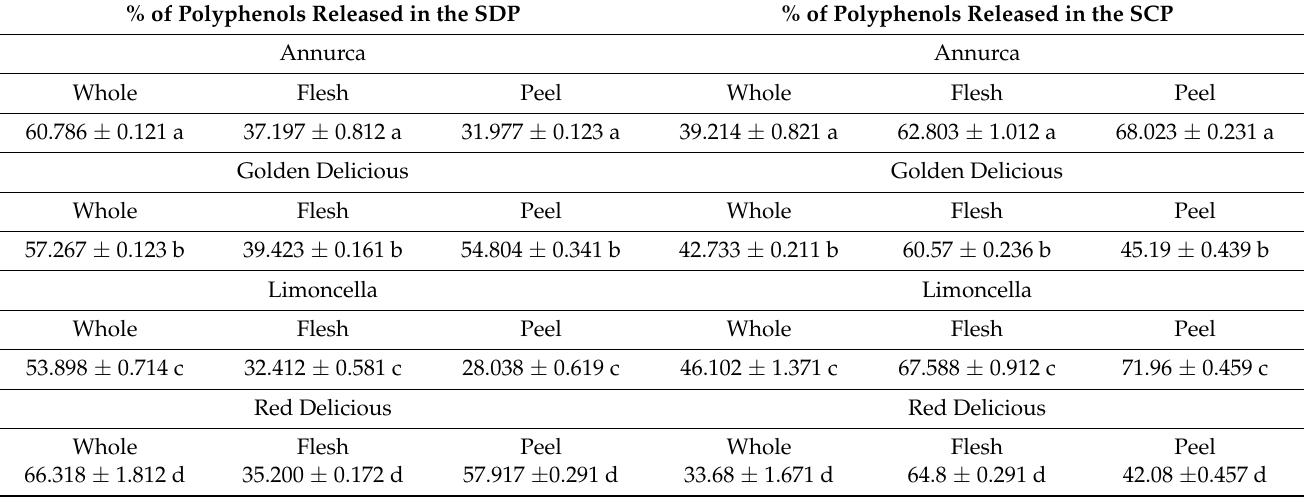
Table 7. % of polyphenols released in the soluble duodenal phase (SDP) and in soluble colonic phase (SCP) upon enzymatic digestion of apple sample. Each value represents the mean of three replicates. Different letters denote a significant difference ( p < 0.05 according to Tukey’s test) between cultivars within flesh, peel, and whole fruit. % of Polyphenols Released in the SDP % of Polyphenols Released in the SCP Annurca